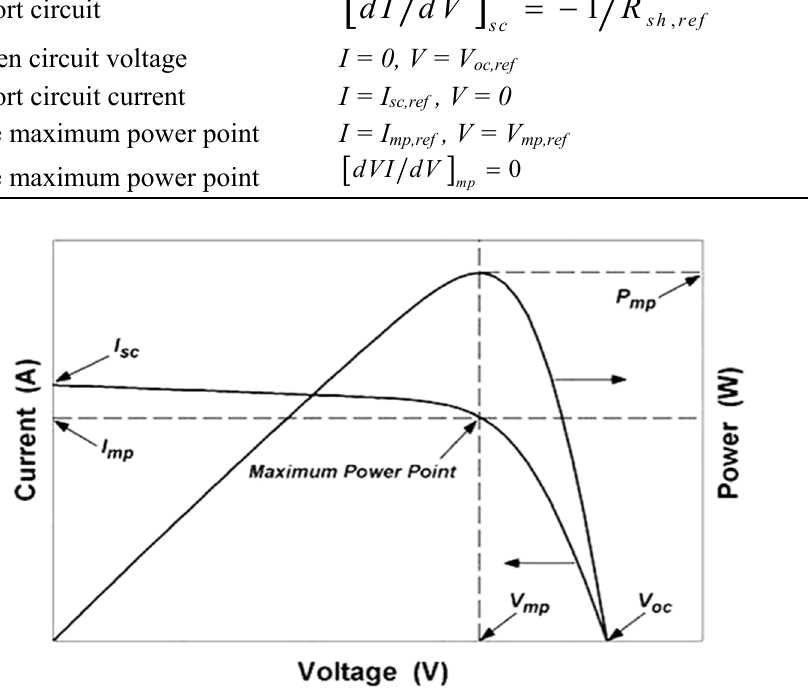
Figure 5. I-V and P-V curves for a PV